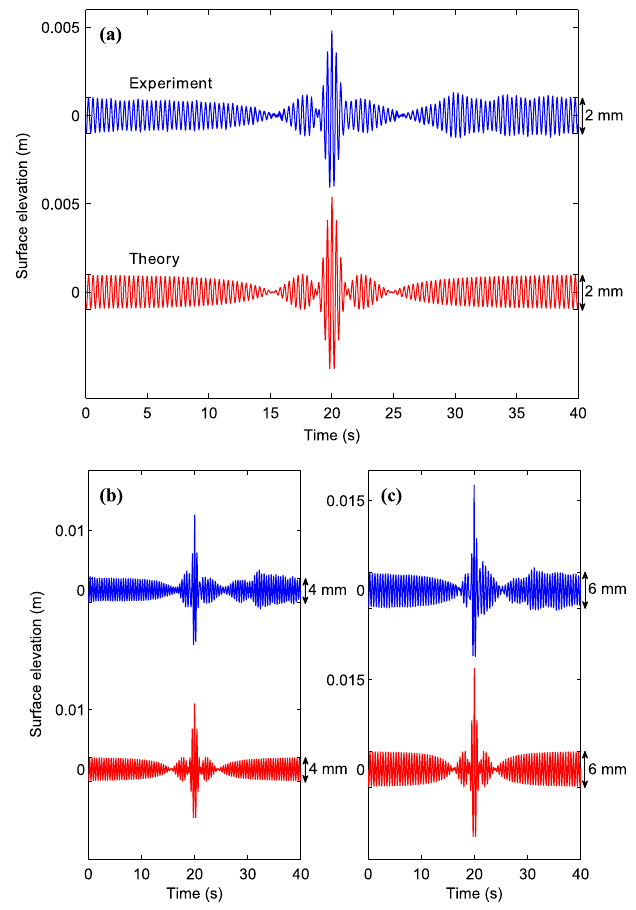
FIG. 6. Three clear observations of the higher-order RWs. Top (blue) curves: Measured wave profile at the expected position of the maximal carrier amplification, (a) for the background am- plitude a 0 ¼ 0 : 001 m and the steepness " ¼ 0 : 03 , (b) for a 0 ¼ 0 : 003 m and " ¼ 0 : 05 . 0 : 002 m and " ¼ 0 : 04 , and (c) for a 0 ¼ For comparison, the bottom (red) curves correspond to the theoretically predicted temporal profile at the same